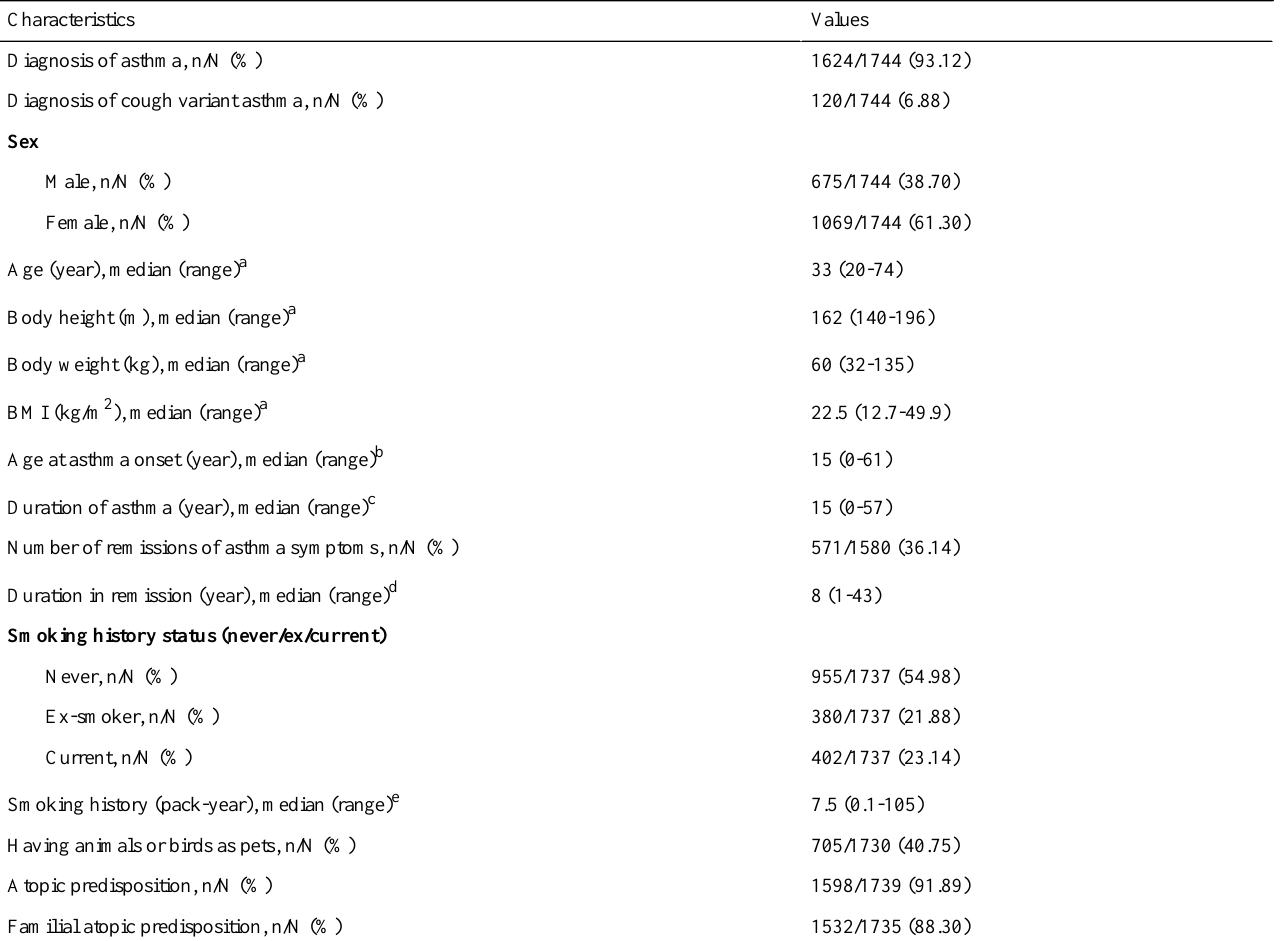
Table 1. Demographic characteristics of Zensoku-Log users.